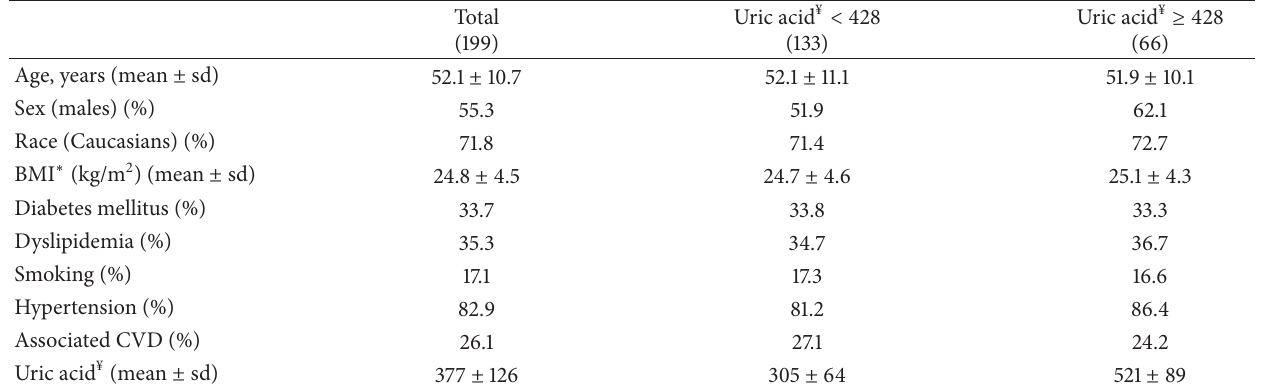
Table 2: Characteristics of the patients after renal transplantation.